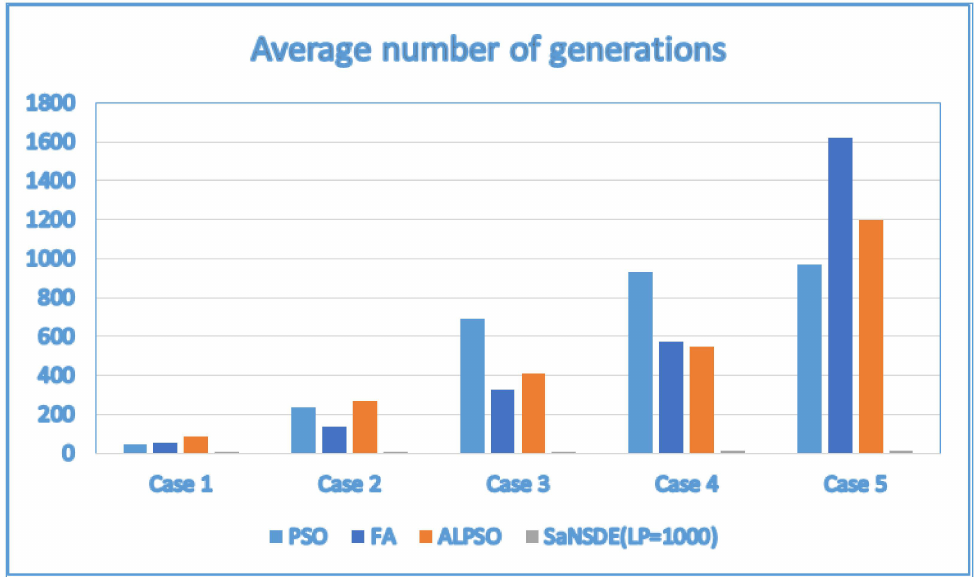
Figure 9. The average number of generations obtained by PSO, FA, ALPSO and SaNSDE with LP = 1000 for Case 1, Case 2, Case 3, Case 4 and Case 5.